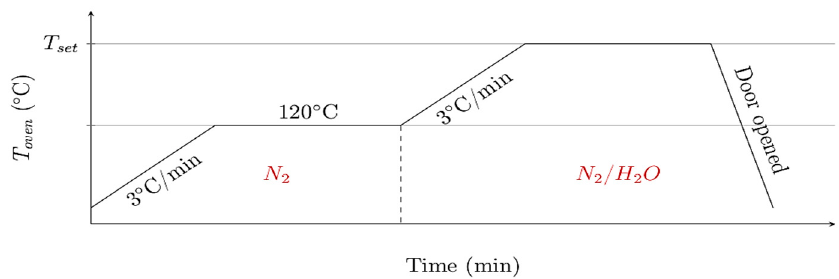
Figure 2. Oven temperature program in terms of temperature, time and torrefaction atmosphere.